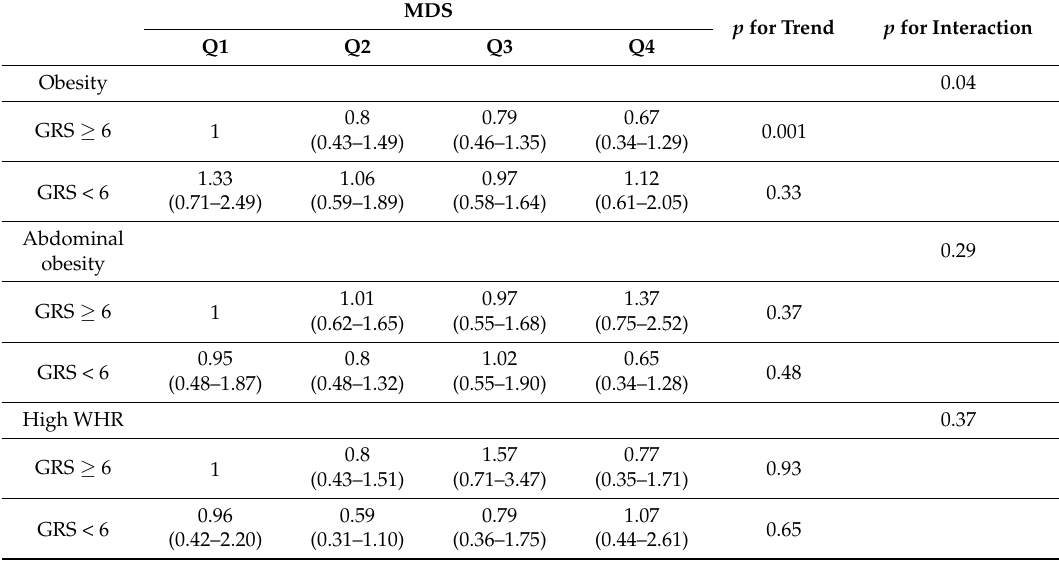
Table 6. Adjusted ORs (95%CI) a for obesity and abdominal obesity according to quartiles of MDS by GRS b